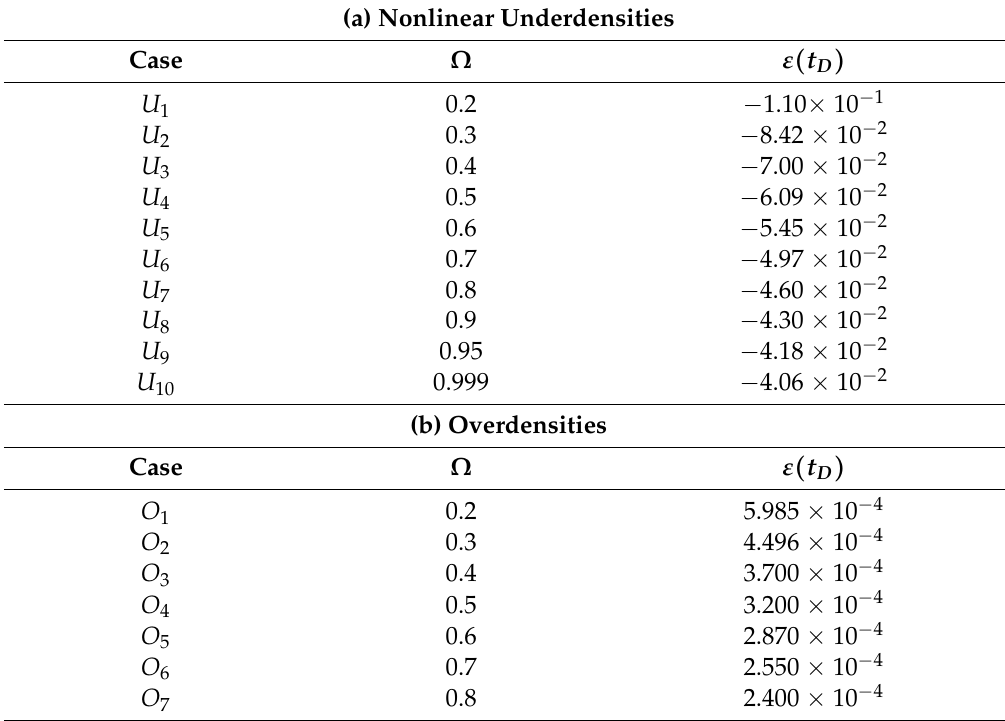
Figure 4. Present nonlinear negative density contrast as a function of R , for the perturbations U 1 − U 10 , with R v ( t 0 ) = 22.5 h − 1 Mpc and ε ( t 0 ) = − 0.74. The initial values at t D that generate each underdensity appear in Table 1a. Table 1. Initial parameters, for universes with different Ω , with the same present energy density contrast, δ